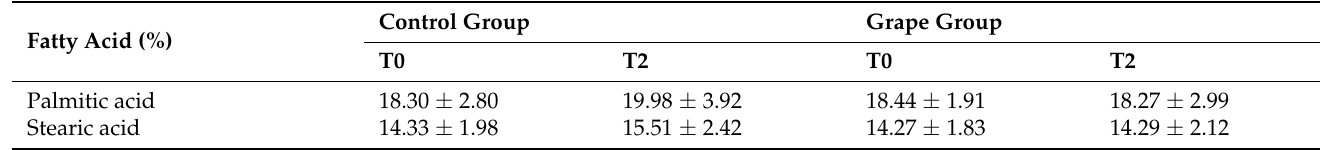
Table 2. Fatty Acids Content in the Serum from Control and Grape Group at Baseline (T0) and after 4 Weeks from the End of Treatment